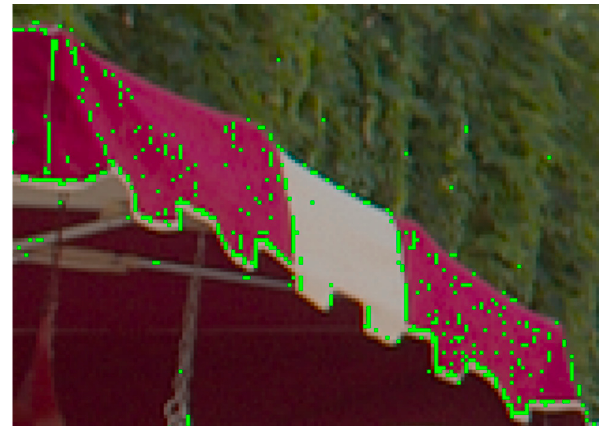
Figure A2. Top 1.5% pixels having the biggest quality difference between the proposed and the fast luma control schemes. The green pixels are attributed mostly to the tPSNR-Y difference between the “Fast” and the “Proposed” luma control schemes.